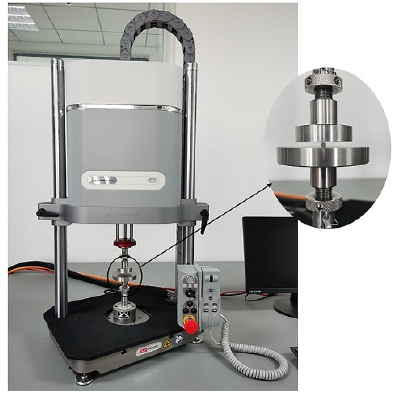
Figure 2. E1000 universal material testing machine.